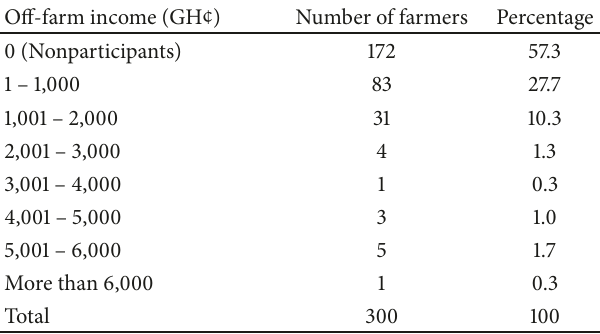
Table 2: Distribution of amount of income earned from off-farm work by